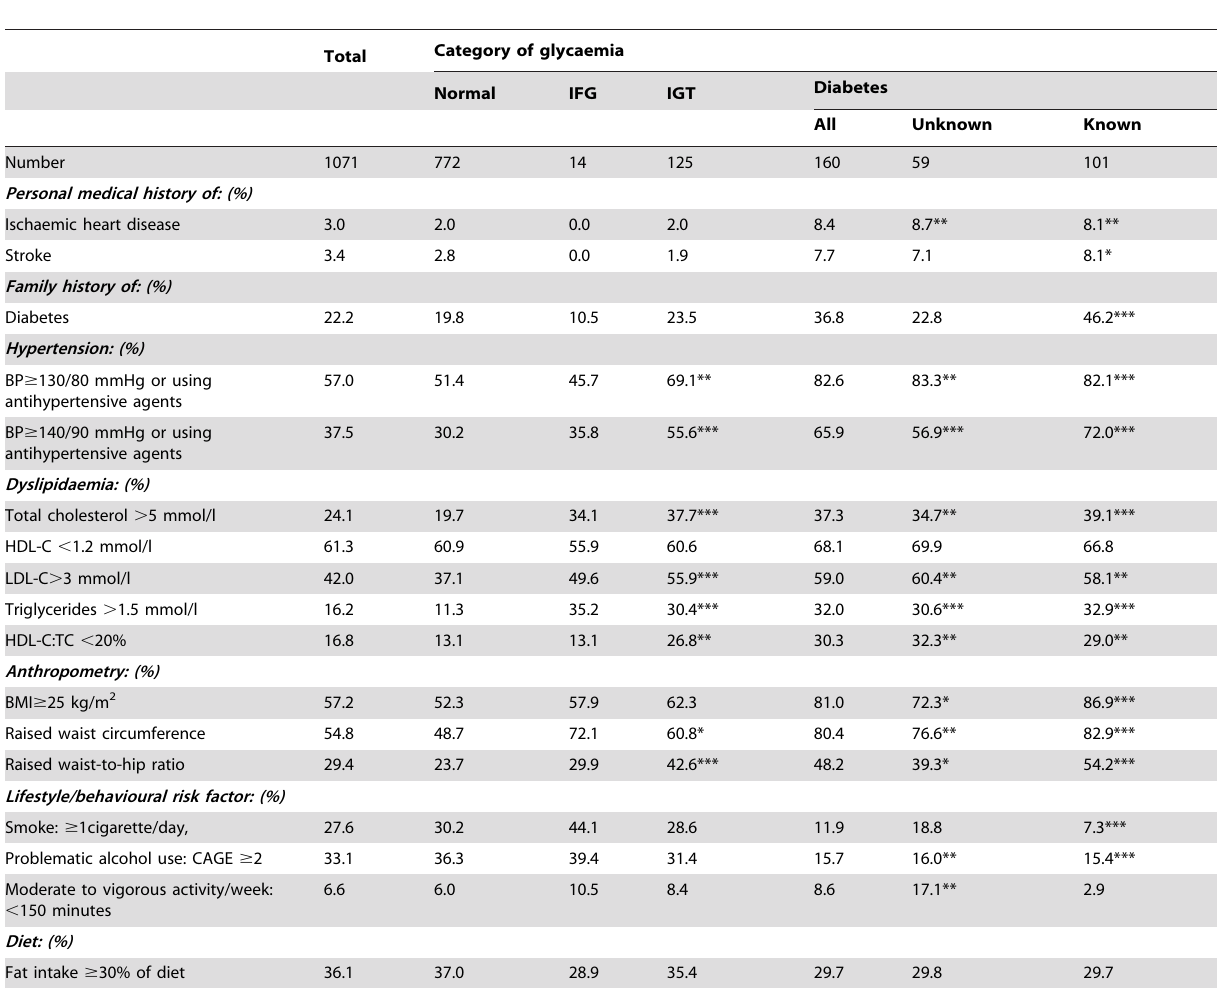
Table 3. Prevalence of cardiovascular disease and risk factors presented by glycaemic categories based on 1998 WHO criteria (n=1071) a